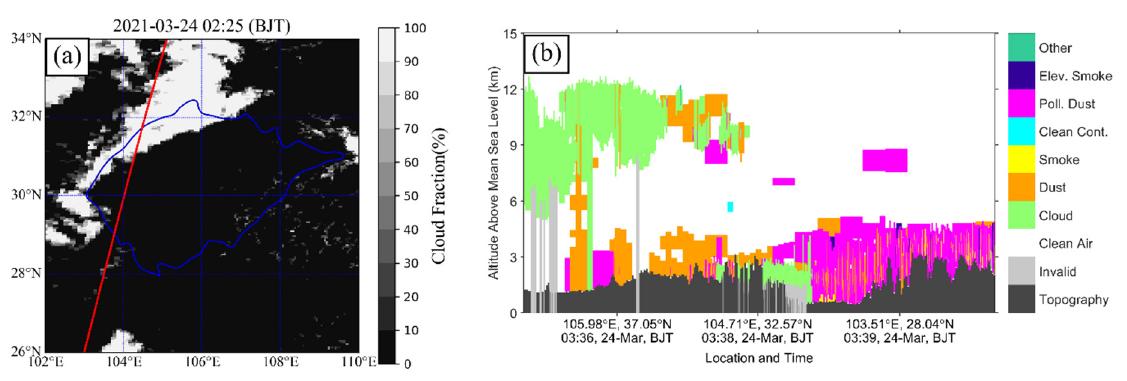
Figure 5. The distribution of MODIS Cloud fractions and the path of CALIPSO sub-satellite point ( a ) and the vertical mask features from CALIOP ( b ) around 03:38 a.m. BJT on 24 March 2021. The red line was the same as those in Figure 4.